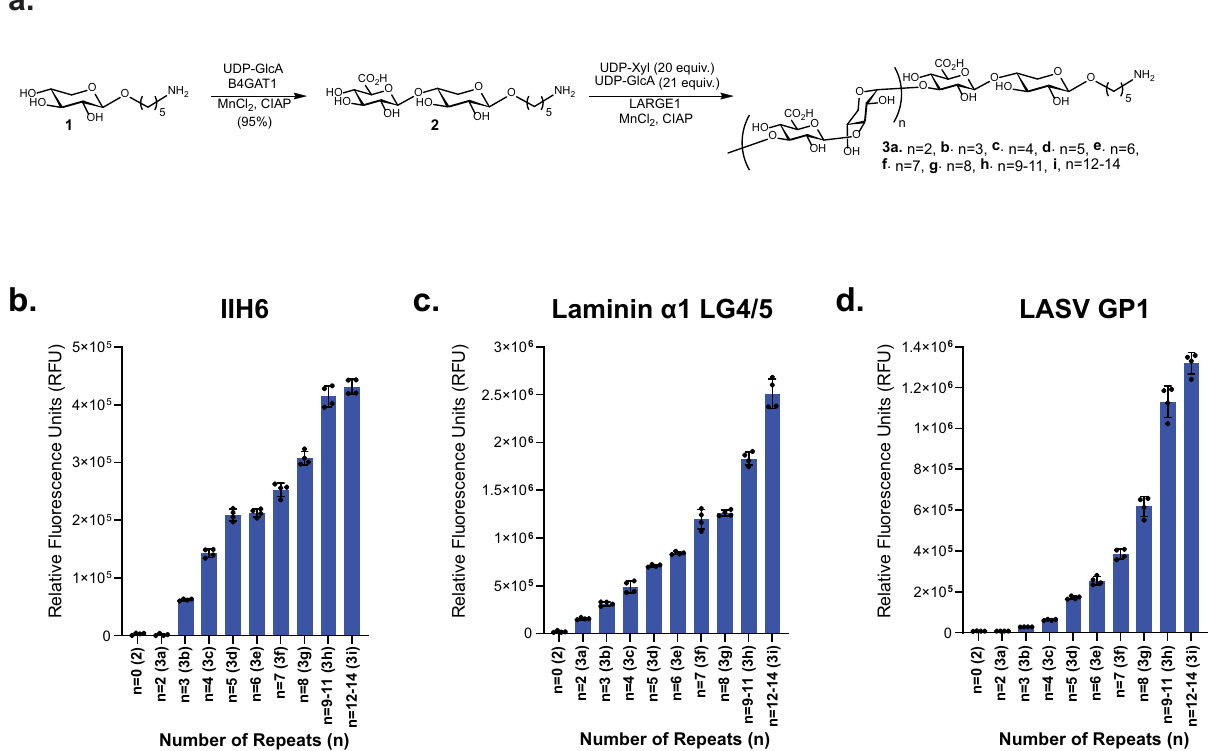
Fig. 2 Matriglycan microarrays of de fi ned lengths for binding studies. a Chemoenzymatic synthesis scheme of de fi ned lengths of matriglycan. b – d Microarray binding results with the matriglycan library at 100 μ M utilizing b mAb IIH6 at 5 μ g mL − 1 , c recombinantly-tagged LG4-LG5 domains of technical replicates, where bars represent the mean and error bars represent SD. Source data of b – d are provided as a Source Data fi